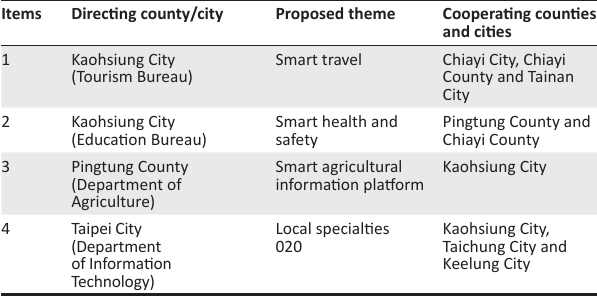
TABLE 4 : Projects for promoting smart city development at Kaohsiung City